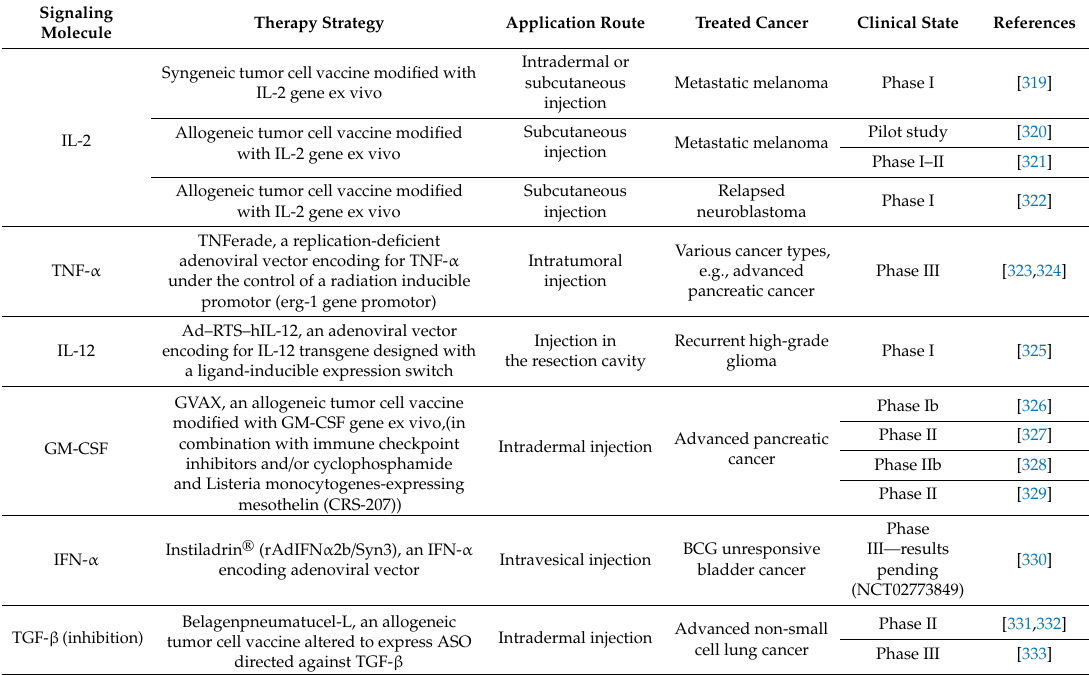
Table 1. Examples of clinical trials investigating nucleic acid-based approaches for adjusting intratumoral cytokine